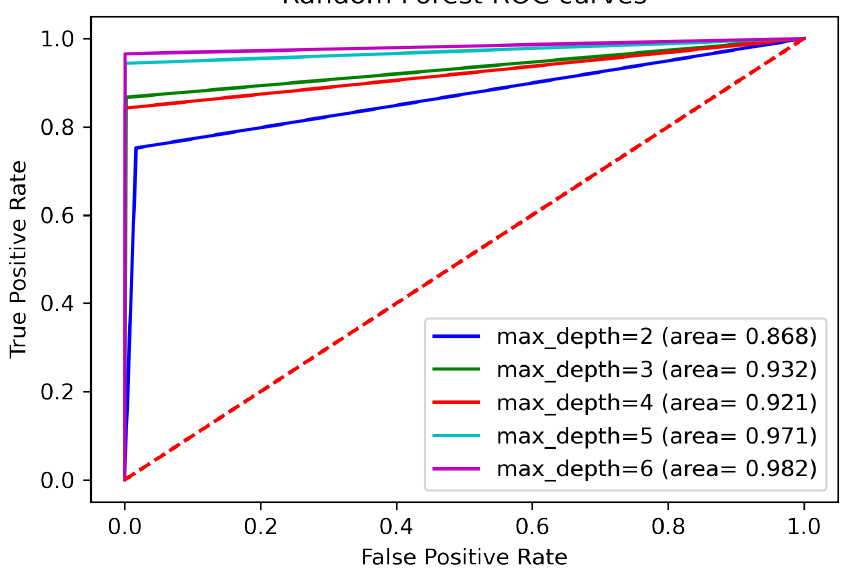
Figure 11. ROC curve comparing the performances with varying values of max_depth.